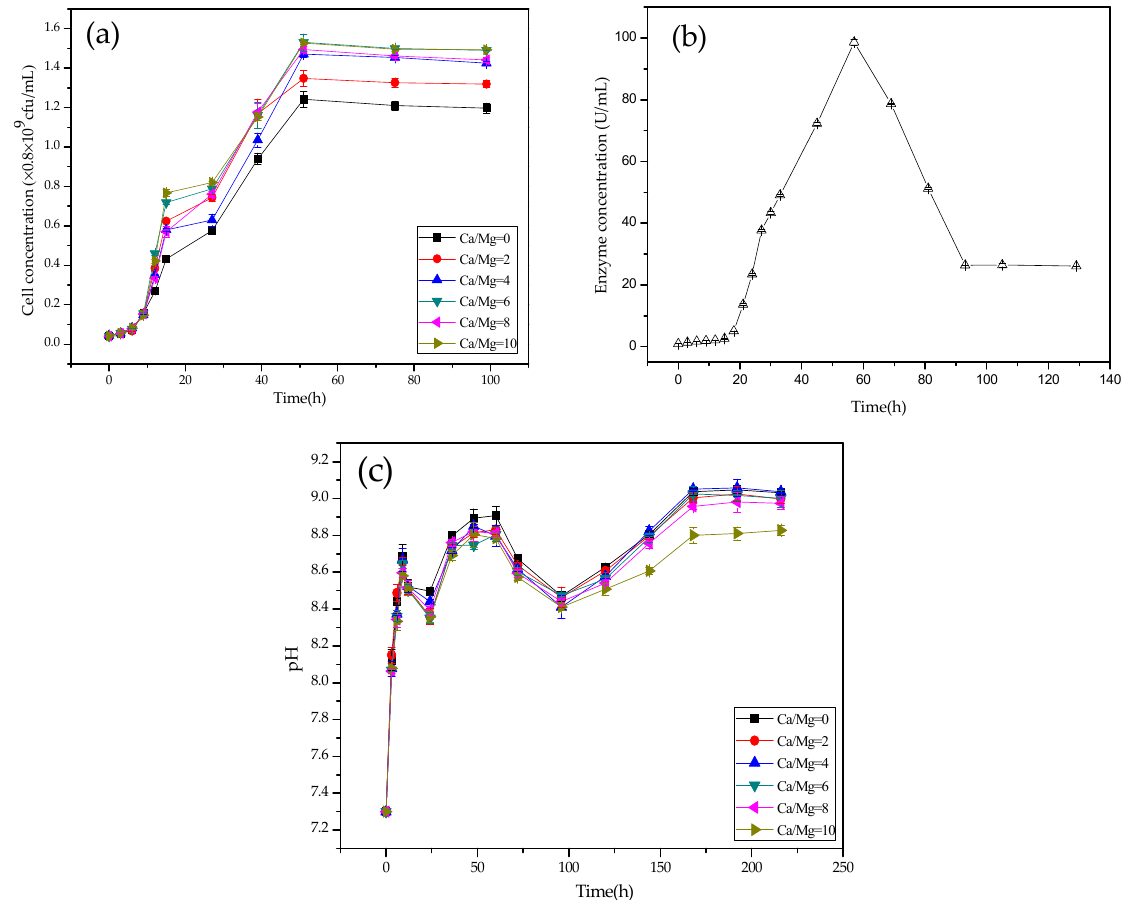
Figure 4. Growth curves, enzyme activity curve and pH curves of LD532 bacteria at different Mg/Ca molar ratios: ( a ) growth curves; ( b ) CA activity curve; and ( c ) pH curves.